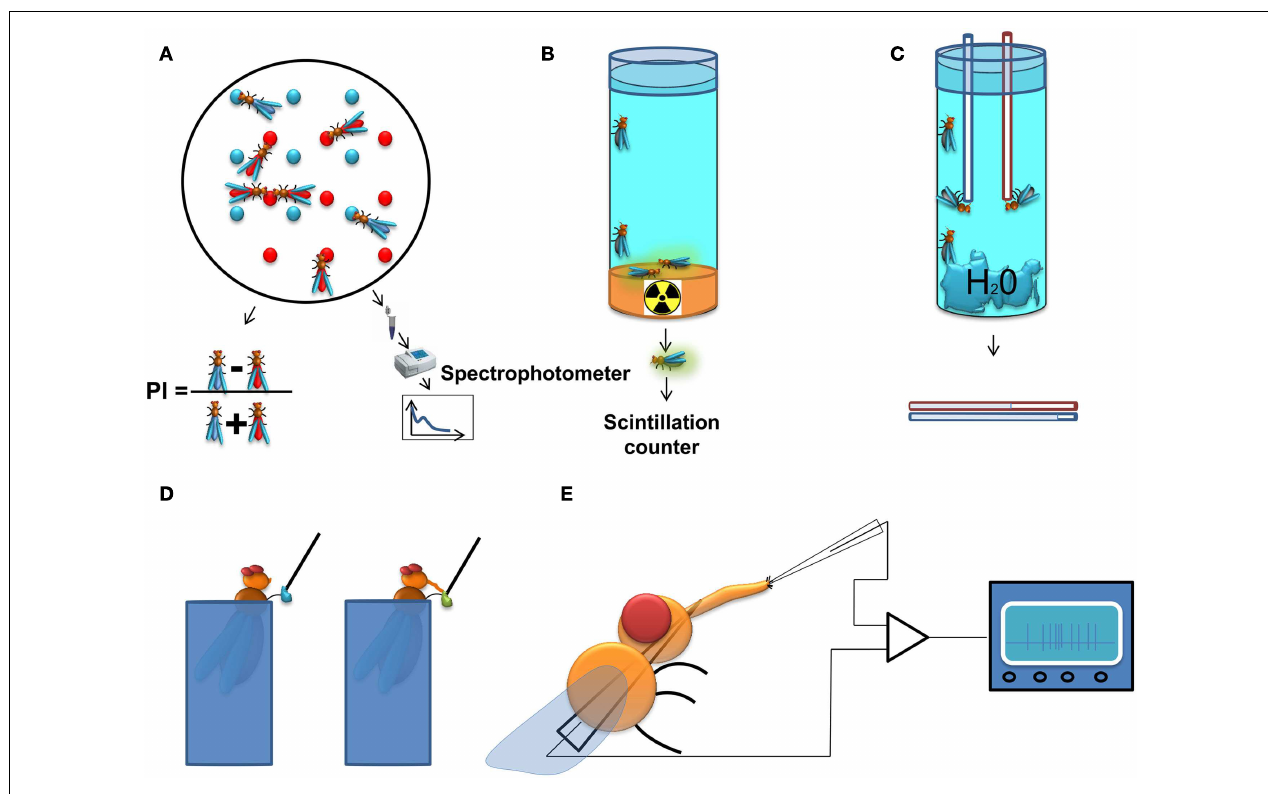
to measure gross food intake, or with multiple capillaries with different food sources, thus providing quantitative information about the food preference of the flies. (D) Proboscis extension response (PER). In this assay the experimenter scores the probability of extension of the proboscis upon stimulation of the gustatory sensilla on the tarsi (depicted on the figure) or the labellum by a tastant solution. (E) Electrophysiological recording from gustatory sensillum. A fly is immobilized and a reference electrode is inserted through the thorax until it reaches the tip of the labellum.The recording electrode containing the tastant solution mixed with an electrolyte is positioned above the sensillum and the spiking activity of gustatory receptor neurons is registered and